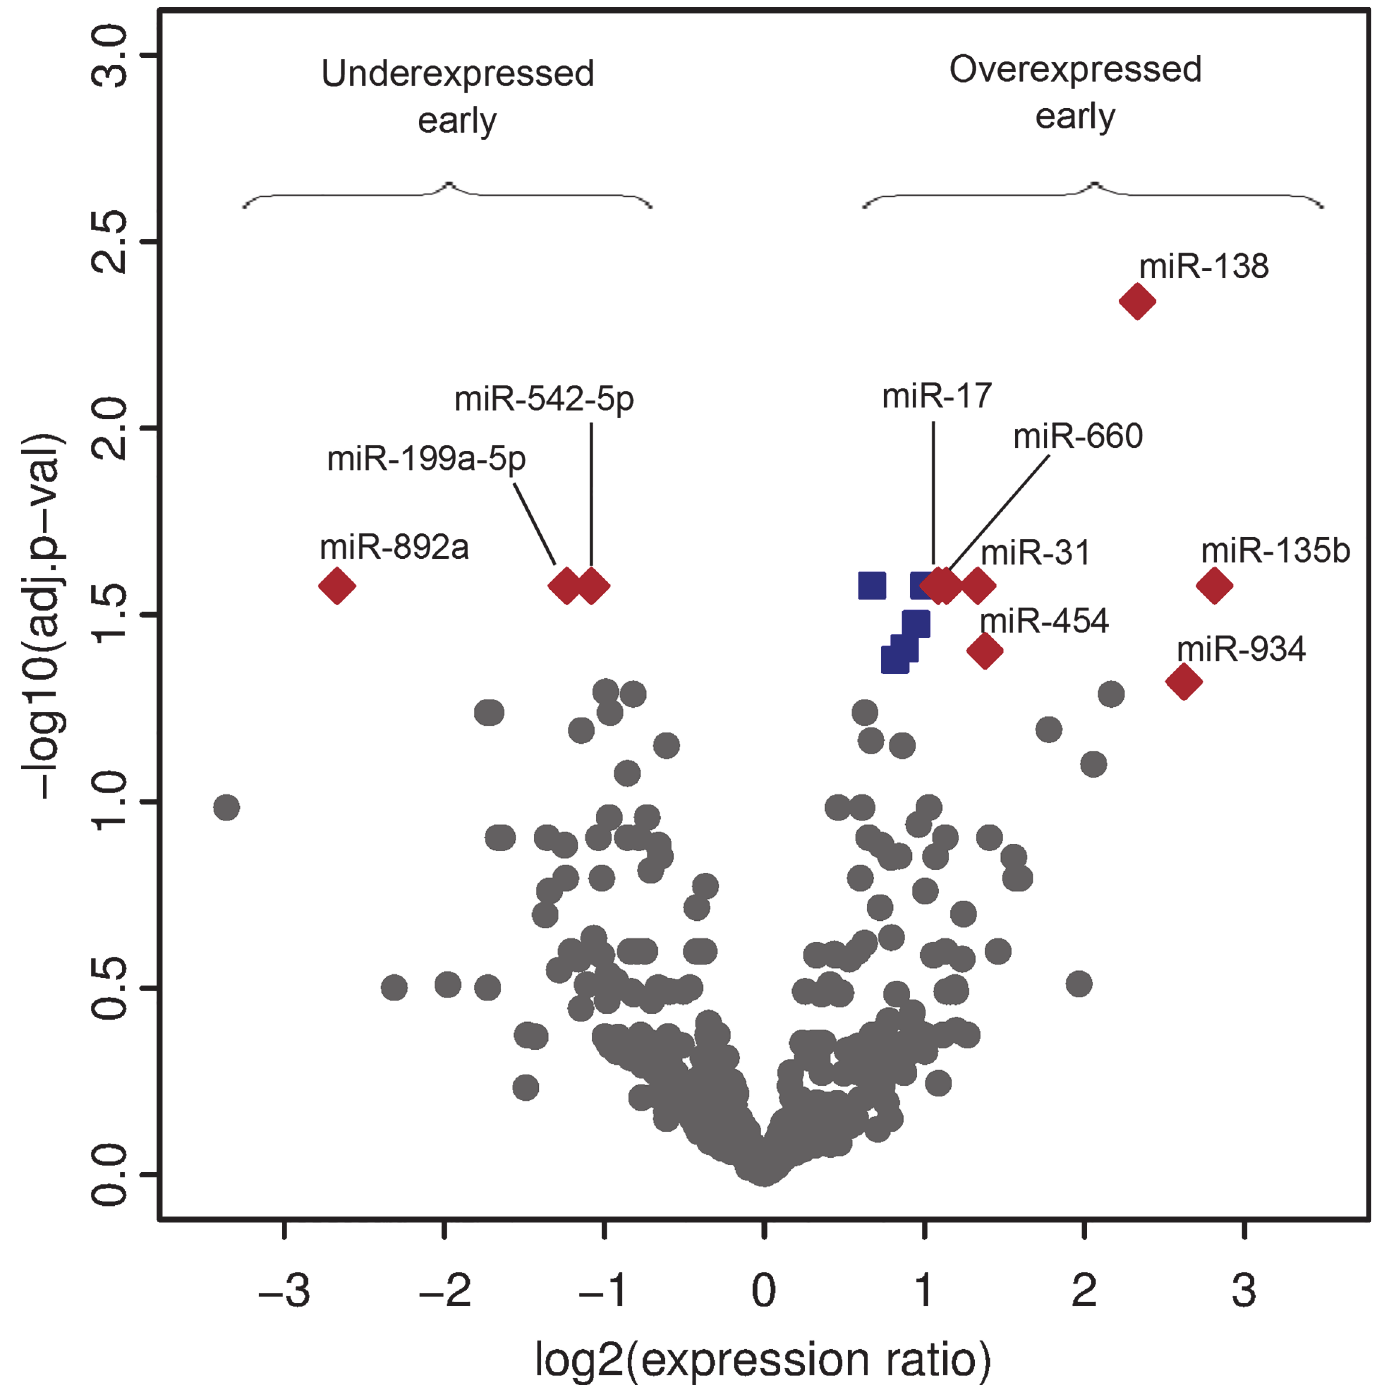
Fig 3. Volcano plot of differentially expressed miRNAs. Comparing miRNAs expressed in Ella FFPE case series; early (diagnosed (cid:1) 5.2 years postpartum) and late (diagnosed (cid:3) 5.3 years postpartum). The x-axis represents the log base 2 of the miRNA expression ratio. The y-axis represents the negative log base 10 of the adjusted p-value. Red diamonds represent miRNAs meeting stringency cut-off (expression ratio (cid:3) 2-fold and an adjusted p- value < 0.05). Blue squares represent additional miRNAs with an adjusted p-value < 0.05. Gray dots represent the remaining miRNAs tested.